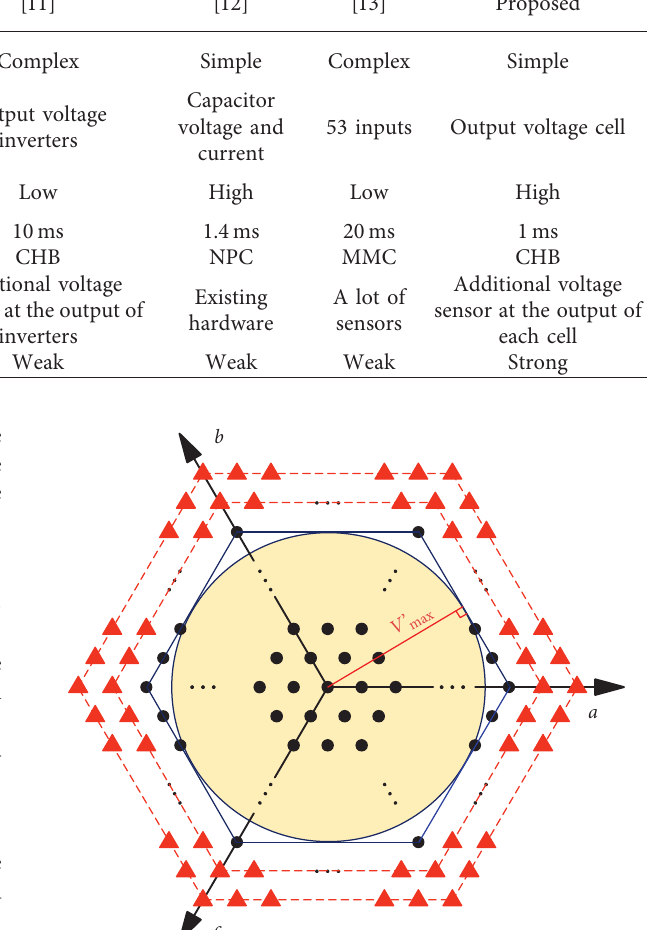
Figure 7: Calculating maximum voltage vector in faulty condition.